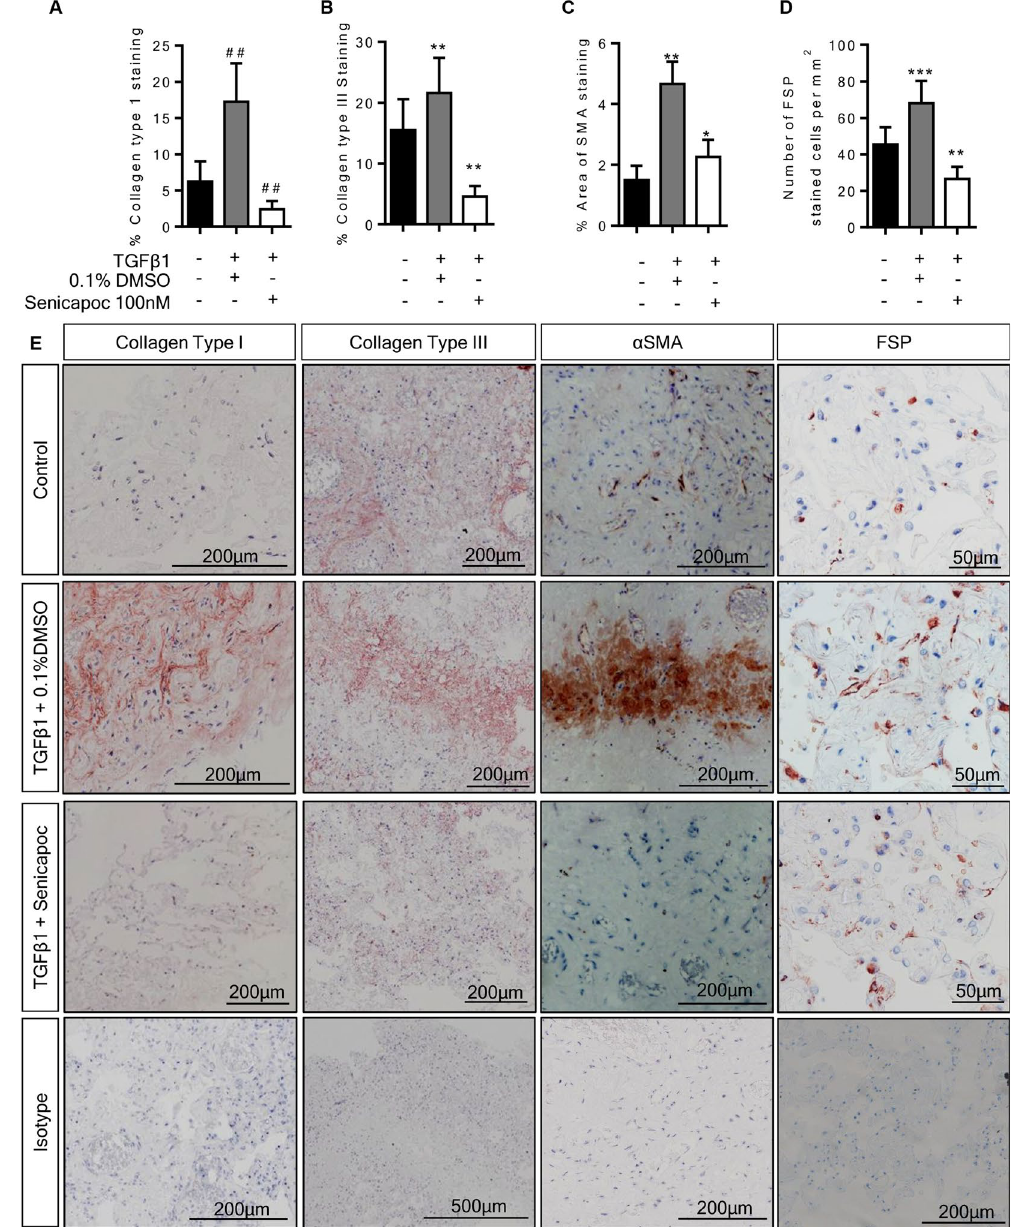
Figure 5. Senicapoc inhibits TGF β 1-induced pro-fibrotic structural responses in the 7 day ex vivo tissue model. ( A ) Analysis of production of collagen type I, collagen type III, α SMA, and fibroblast cell numbers following exposure to TGF β 1 with or without the K Ca 3.1 inhibitor senicapoc (100 nM). 0.1% DMSO was used as vehicle control. Senicapoc significantly attenuated TGF β 1-dependent pro-fibrotic responses within the tissue over 7 days ex vivo culture, n = 10 individual donors. Data are presented as median ± IQR, ## P < 0.01 (Wilcoxon matched pairs signed rank test), or mean ± SEM ** P < 0.01, *** P < 0.001 (paired t test). ( B ) Representative immunohistochemical images of 7 day ex vivo culture tissue under various conditions, un-stimulated control, TGF β 1-stimulated plus 0.1% DMSO and TGF β 1-stimulated treated with senicapoc (100 nM). Control and treated tissues were